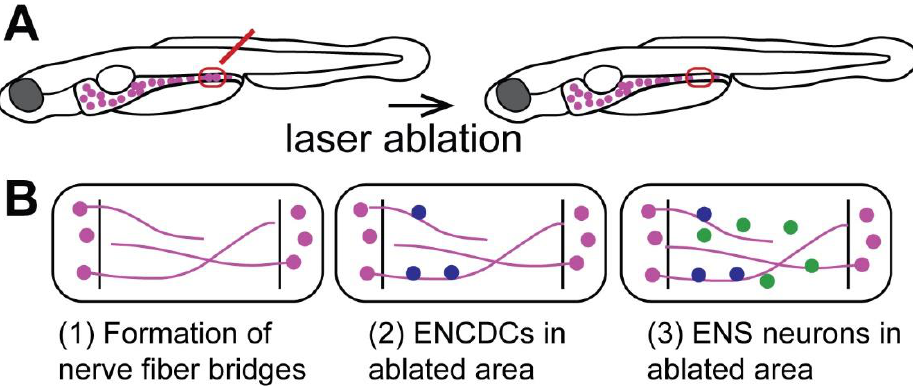
Figure 3. Regenerative processes in the zebrafish ENS after cell ablation. ( A ) Experimental setup of focal laser ablation (red) of a small set of ENS neurons in the zebrafish larvae. ( B ) Steps of regenerative processes in the zebrafish ENS in the ablated area marked by lines: ( 1 ) formation of nerve fiber bridge across the ablated area; ( 2 ) enteric neural crest-derived cells (ENCDCs, blue) appear in the ablated area; ( 3 ) new neurons (green) are generated in the ablated area